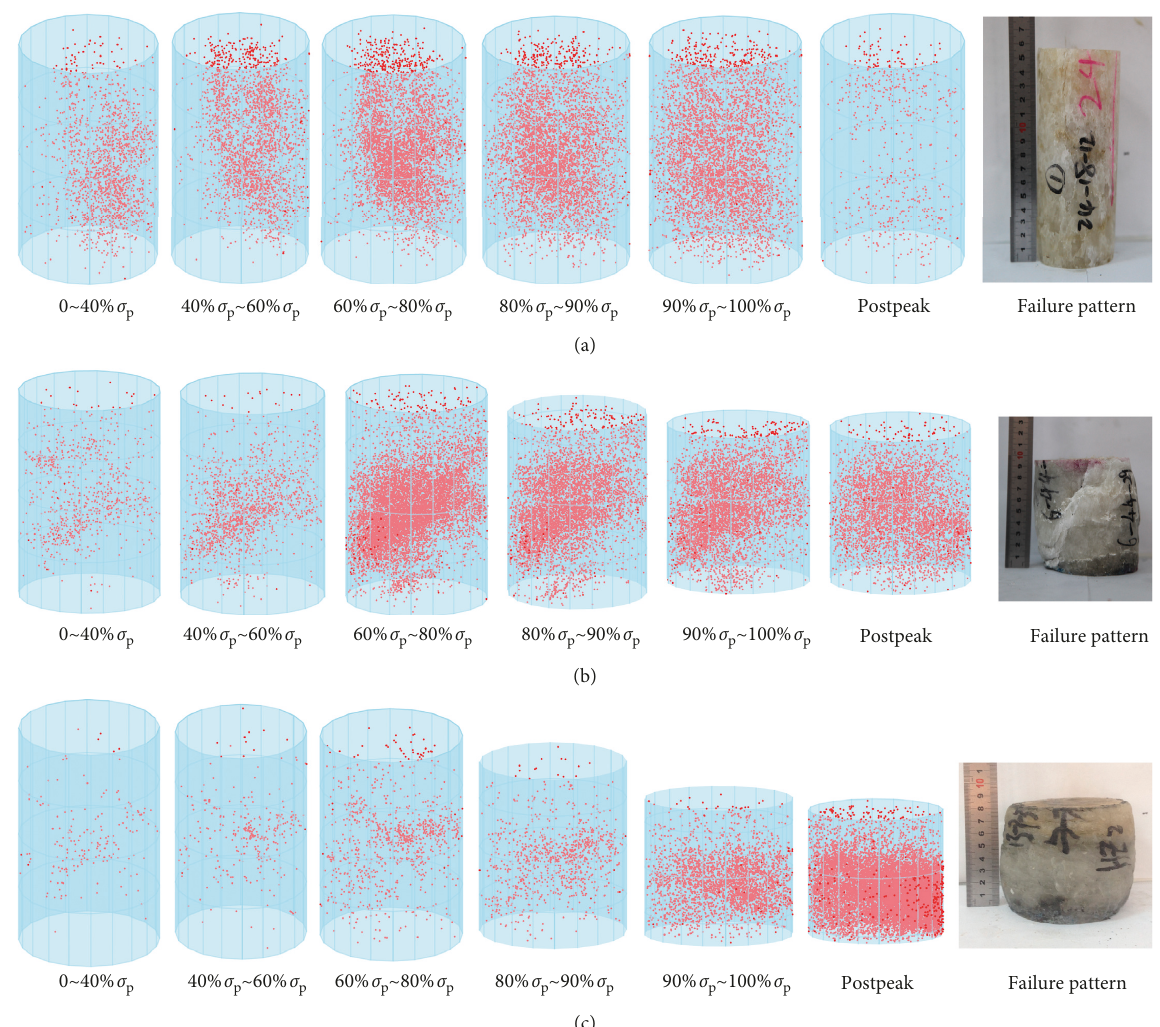
Figure 8: Spatial distribution of AE events and failure patterns of rock salt at different confining pressures. (a) σ (c) σ 3 �